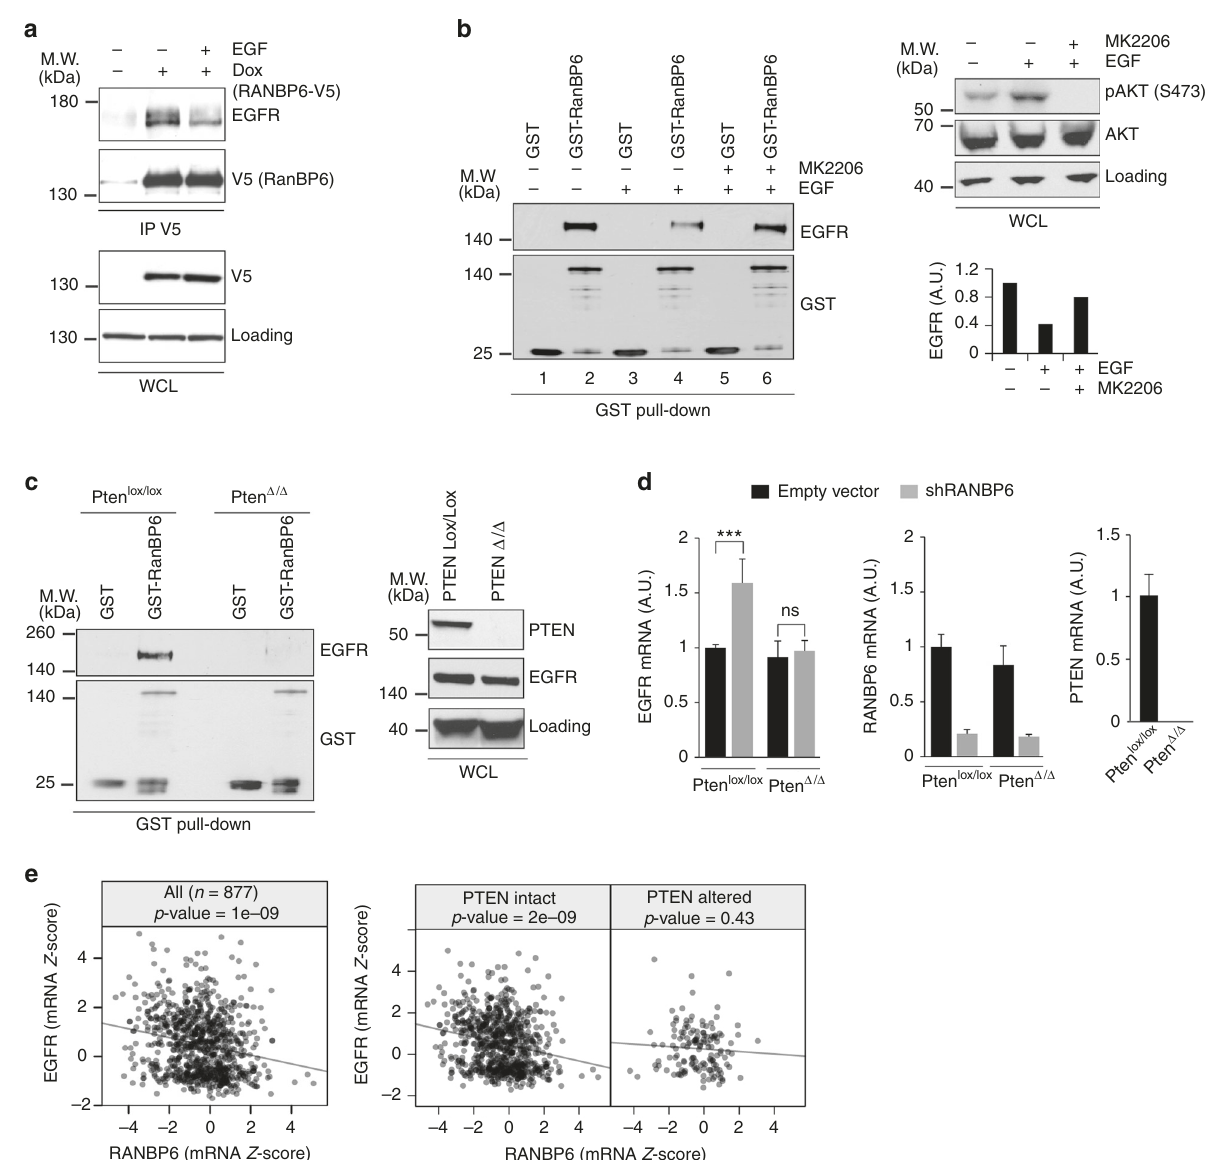
Fig. 5 EGFR regulation by RanBP6 is disrupted in PTEN-de fi cient cells. a Co-immunoprecipitation of EGFR and V5 epitope-tagged RanBP6-V5 in A431 cells serum starved and induced with EGF (100ng/ml) for 5min. Top panel, IP using V5 antibody; bottom panel, immunoblot of whole-cell lysates (WCL). b Interaction of GST-RanBP6 fusion protein with EGFR is Akt dependent. Left panel, GST pulldown; right lower panel, densitometric quanti fi cation of GST pulldown; right upper panel, immunoblot of whole-cell lysate. c PTEN loss disrupts interaction of GST-RanBP6 fusion protein with EGFR. Left panel, GST-RanBP6 fusion protein interacts with EGFR in Pten lox / lox but not Pten Δ / Δ MEFs; Right panel, immunoblot of whole-cell lysates. d RanBP6 KD raises Egfr mRNA level in Pten lox / lox but not Pten Δ / Δ MEFs. Left panel, Egfr mRNA level; middle panel, Ranbp6 mRNA level; right panel, Pten mRNA level. e Left panel, negative correlation between RANBP6 and EGFR mRNA Z -score in the Cancer Cell Line Encyclopedia ( n = 877, Pearson product – moment correlation r = − 0.203, p -value = 1e − 09). Right panels, cancer cell lines were strati fi ed accordingly to PTEN status. Inverse correlation between RANBP6 and EGFR mRNA levels only in PTEN-intact cancer cell lines ( n = 734, Pearson product – moment correlation r = − 0.22, p -value = 2e − 09) but not PTEN altered cell lines ( n = 143, Pearson product – moment correlation r = − 0.066, p -value = 0.43). Data in bar graphs are represented as mean ± SD ( n ≥ 3). Student ’ s t test: *** p < 0.001; ns not signi fi